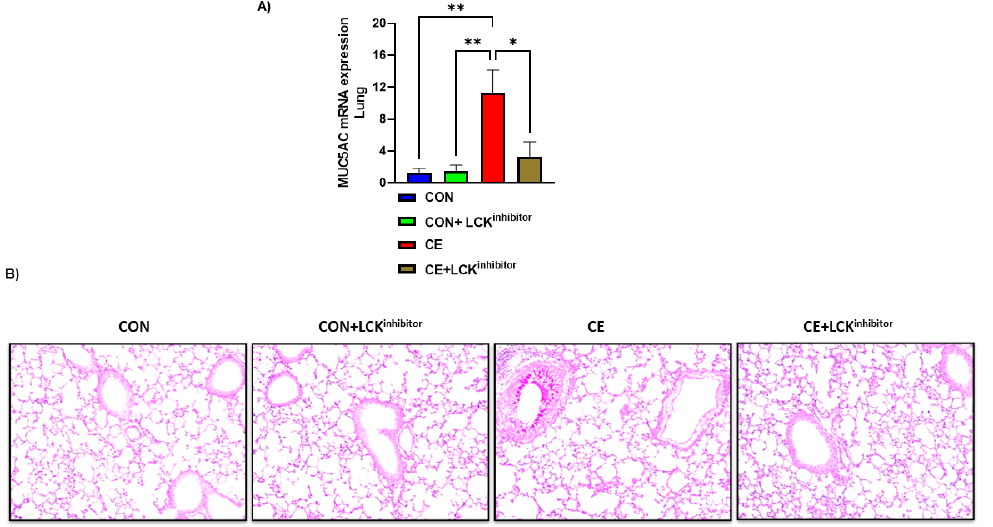
Figure 3. Reduction in mucus production by LCK inhibitor in CE-exposed allergic mice. ( A ) Muc5Ac mRNA expression in lung, ( B ) PAS staining of lung tissue. Data are presented as mean ± SE, n = 6/group. * p < 0.05; ** p < 0.01